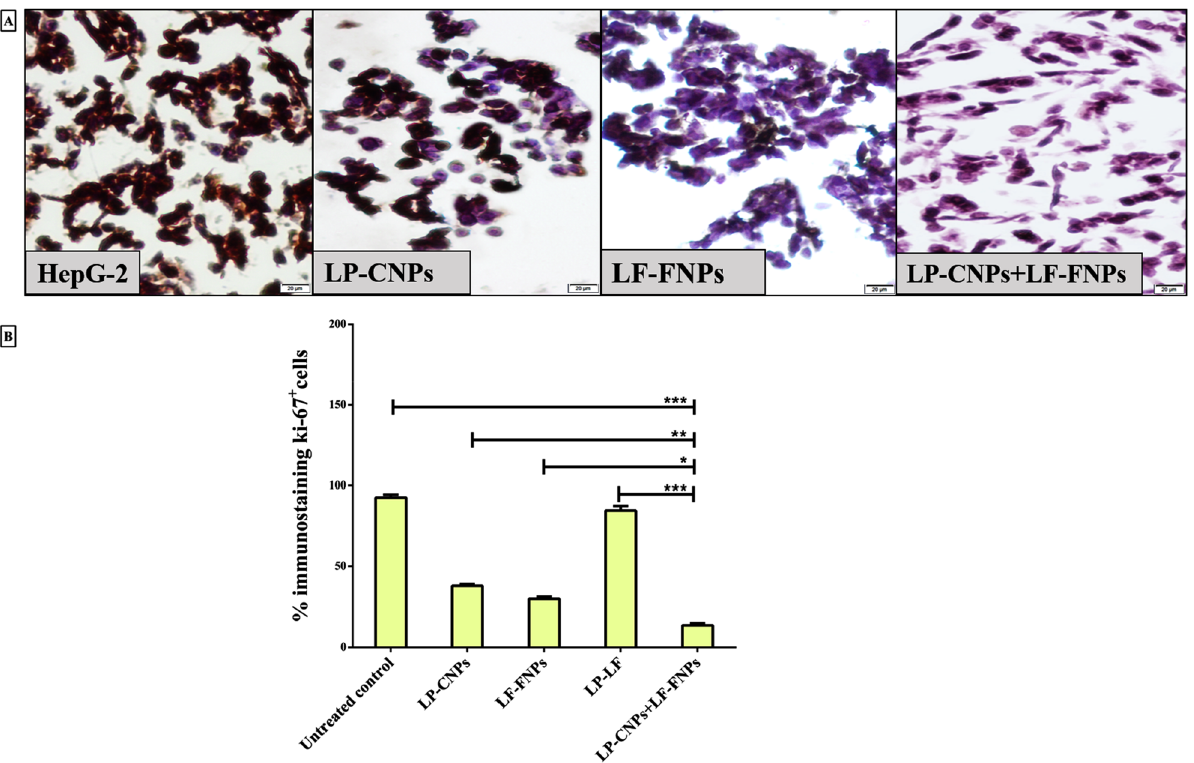
Figure 5. Immunohistochemical analysis of proliferation marker (Ki-67) in HepG2 cells after treatment with the most effective anticancer nanoformulas and LP + LF. ( A ) Immunohistochemical staining images of the untreated and LP-CNPs, LF-FNPs, LF-LP and LP-CNPs + LF-FNPs -treated HepG2 with ( B ) Ppercentage of Ki-67 + -immunostained cell population in the untreated and treated HepG2 cells (Magnification 200 X; scale bar 20 µm). All values are demonstrated as mean ± S.E. LP-CNPs + LF-FNPs are statistically significant with other formulas at p < 0.05*, p < 0.005**, p < 0.0005***. CNPs: CuO nanoparticles; FNPs: iron nanoparticles; LF: lactoferrin; LP: lactoperoxidase. Docked